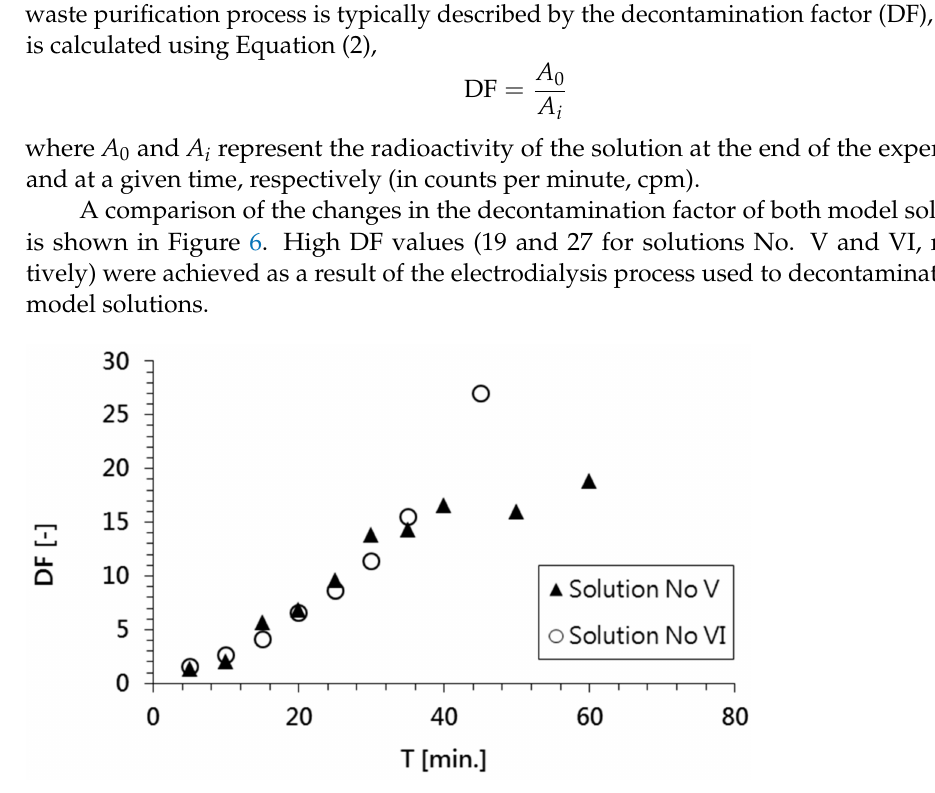
Figure 6. Changes in the decontamination factor during the electrodialysis treatment of solutions No. V and VI.